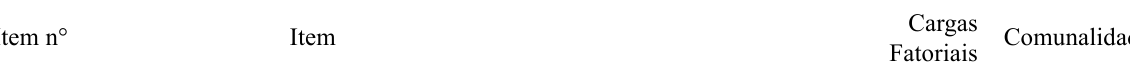
Fator 1: “Internalização”( α